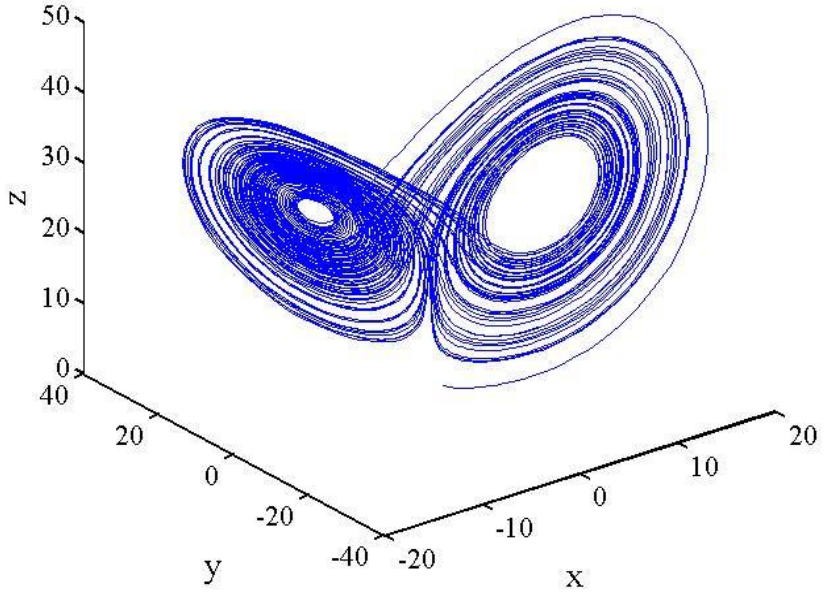
Figure 2. The chaotic attractor in Lorenz system with parameter values σ = 10, β = 8/3 and ρ = 28. In this work, the z ( t ) component of Lorenz system is normalized in the range [0, 1] before being applied to the Jaya algorithm according to Equation (4).